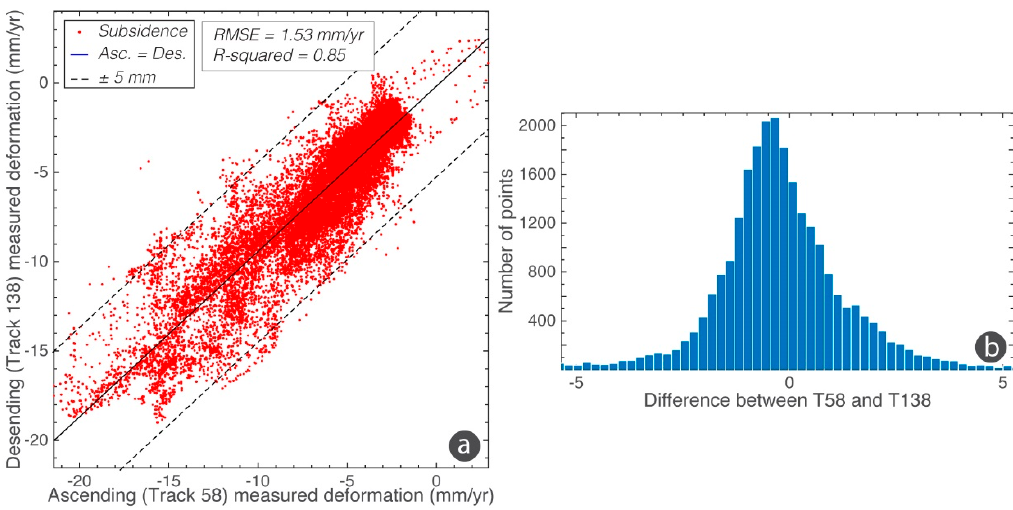
Figure 6. Quantitative comparison of the line-of-sight displacement rates between ascending and descending tracks. ( a ) Correlation between point measurements. ( b ) Differences analysis between T58 Ascending and T138 Descending tracks. Offset from zero is related to local viewing angles’ differences.